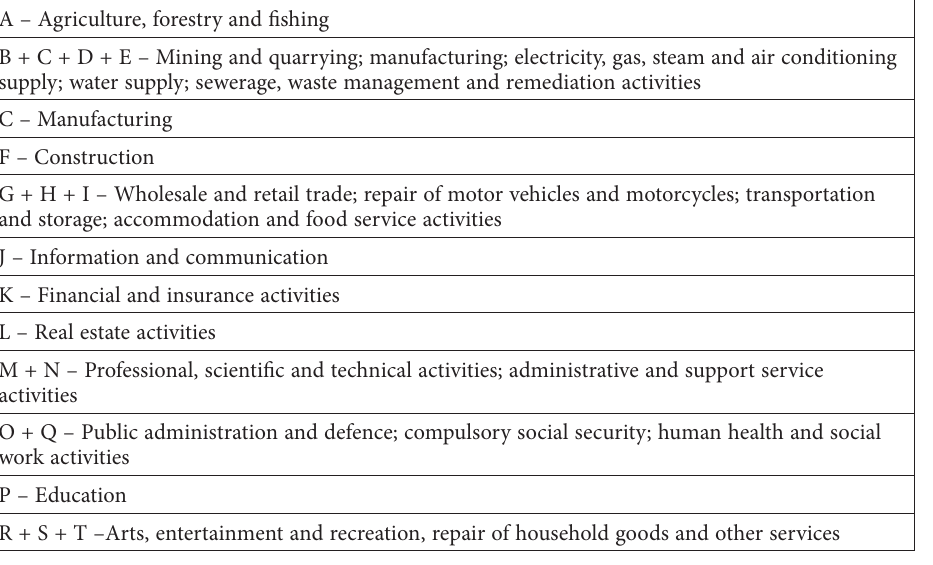
Table 6. Aggregated Input-Output table (source: compiled by